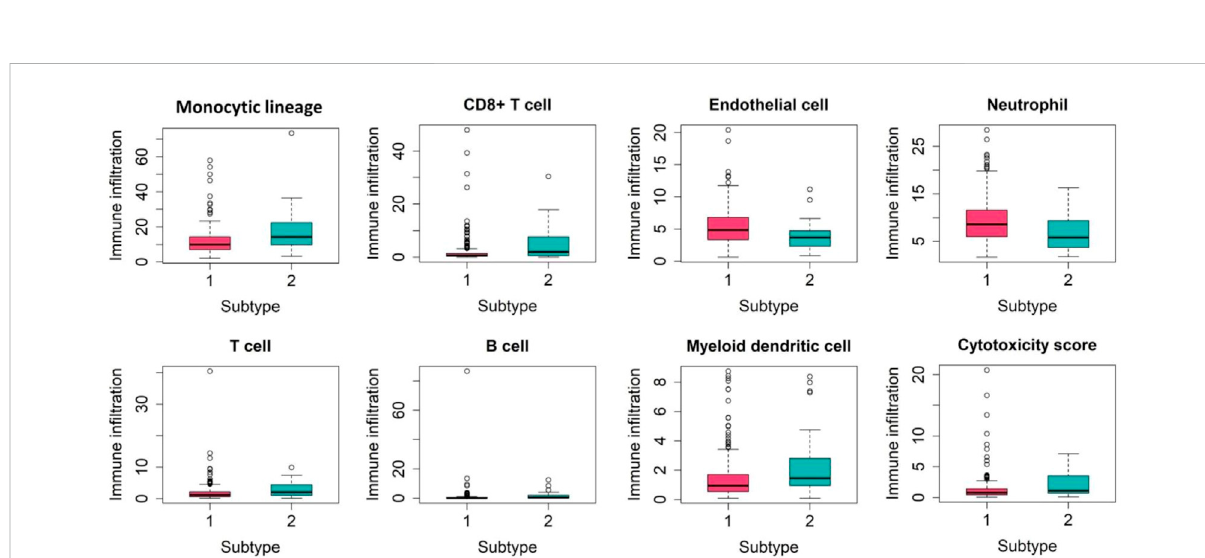
FIGURE 6 Boxplots showing the abundance of nine immune cells between the two